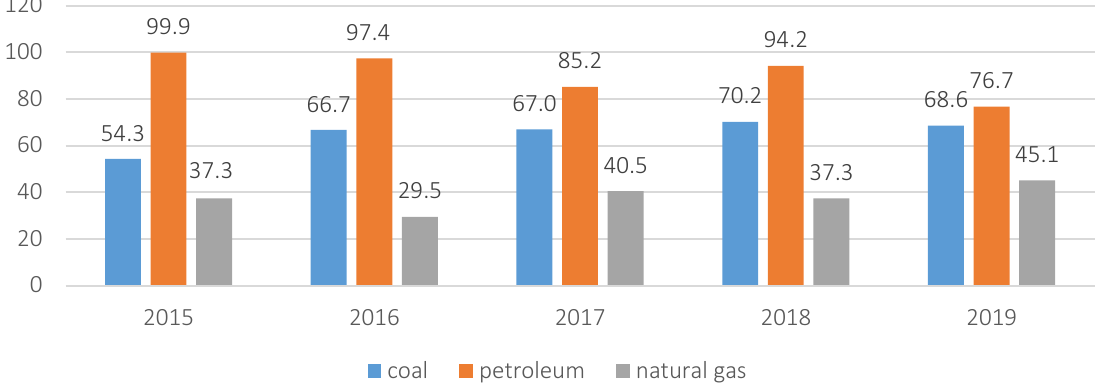
Figure 2. Maximum share of imported primary energy in Ukraine, %